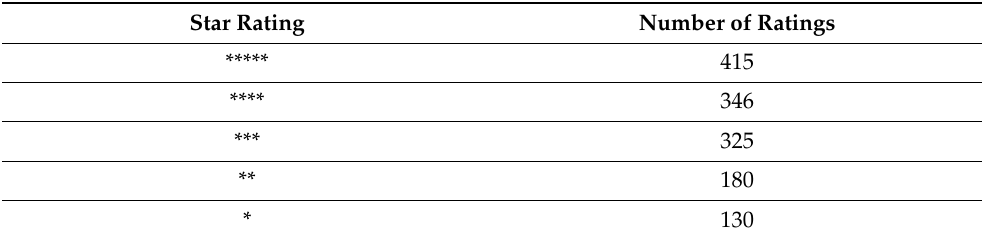
Table 1. Product ratings